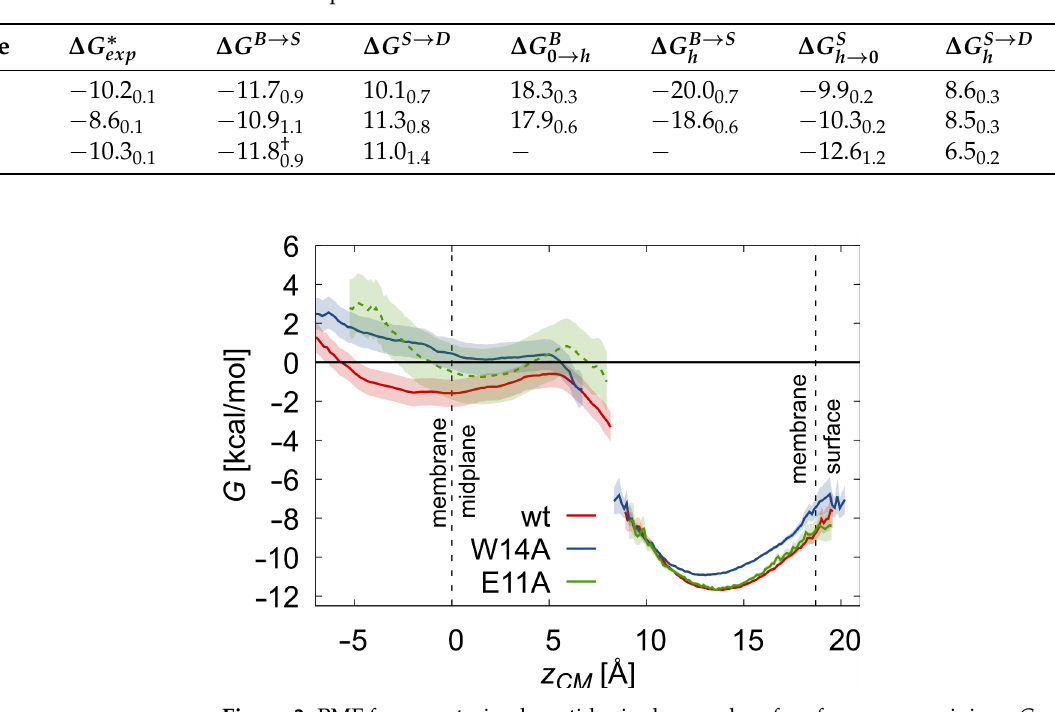
Table 1. Experimental, ∆ G exp , and calculated free energy differences in kcal/mol (error estimates in subscript): ∆ G B → S binding from bulk solvent to membrane surface, ∆ G S → D transition from surface to deep configuration, ∆ G B the cost 0 → h of peptide restraining to hairpin in bulk solvent, ∆ G B → S transition of restrained peptide from bulk solvent to membrane h surface, ∆ G S restraints removal for surface configuration, ∆ G S → D transition of restrained peptide from surface to deep h → 0 h configuration, ∆ G D restraints removal for deep configuragion. ∗ experimental energies are for peptides with solubility h → 0 tags, and † value for E11A based on experimental difference wrt. wt.